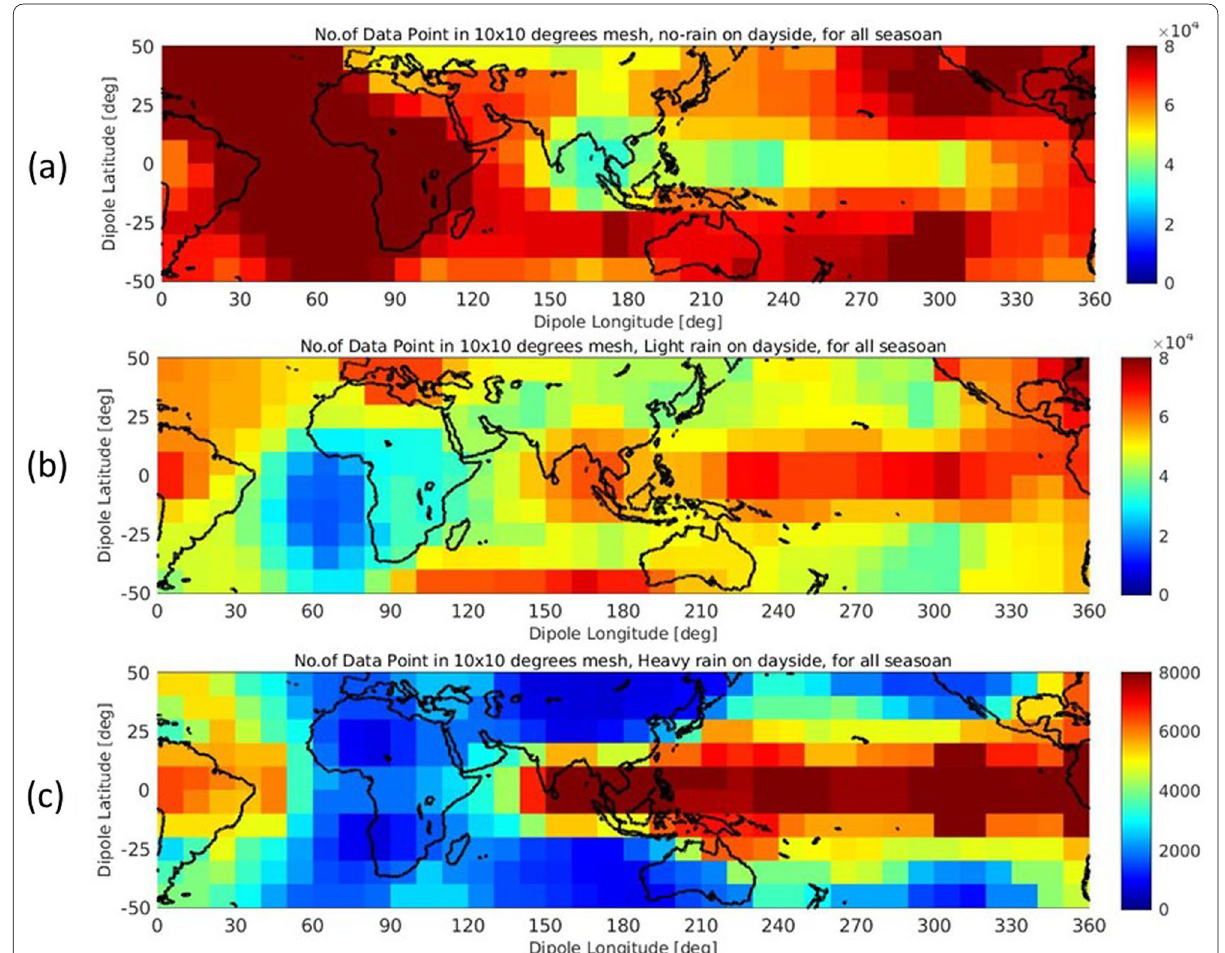
Fig. 7 Number of data points in a 10° 10° mesh used to obtain Figs. 6, 8 , 9 and 11. a No-rain at the satellite footprints at 120 km altitude along × geomagnetic field in both hemispheres, i.e., at P1 and P2 in Fig. 1. b Weak rainfall (< 5 mm/h) at least one of the footprints but no heavy rainfall. c Heavy rainfall (> 5 mm/h) at least one of the footprints, P1 and/or P2. About 130 data points correspond to one satellite path. Note that the color scale for c is 10 times smaller than that for a and